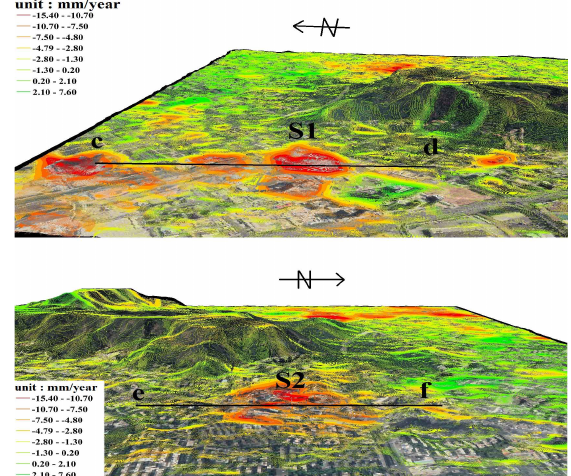
Figure 10. 3D deformation map of the S1 and S2 regions